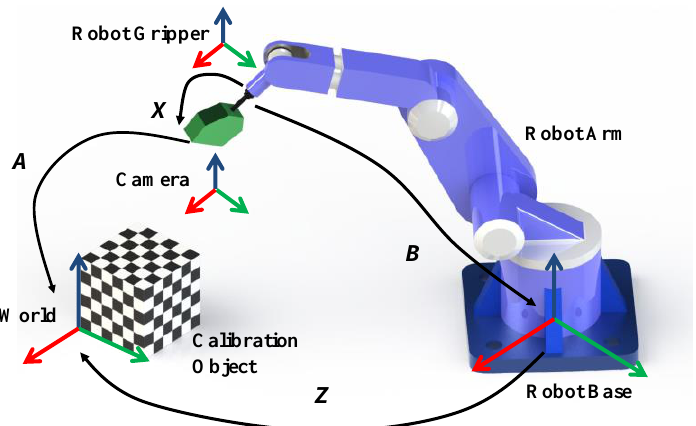
Figure 1. The robotic system of robot – world and hand – eye calibration.